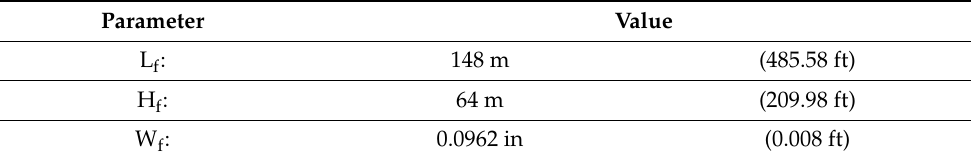
Table 3. Optimized fracture geometrical